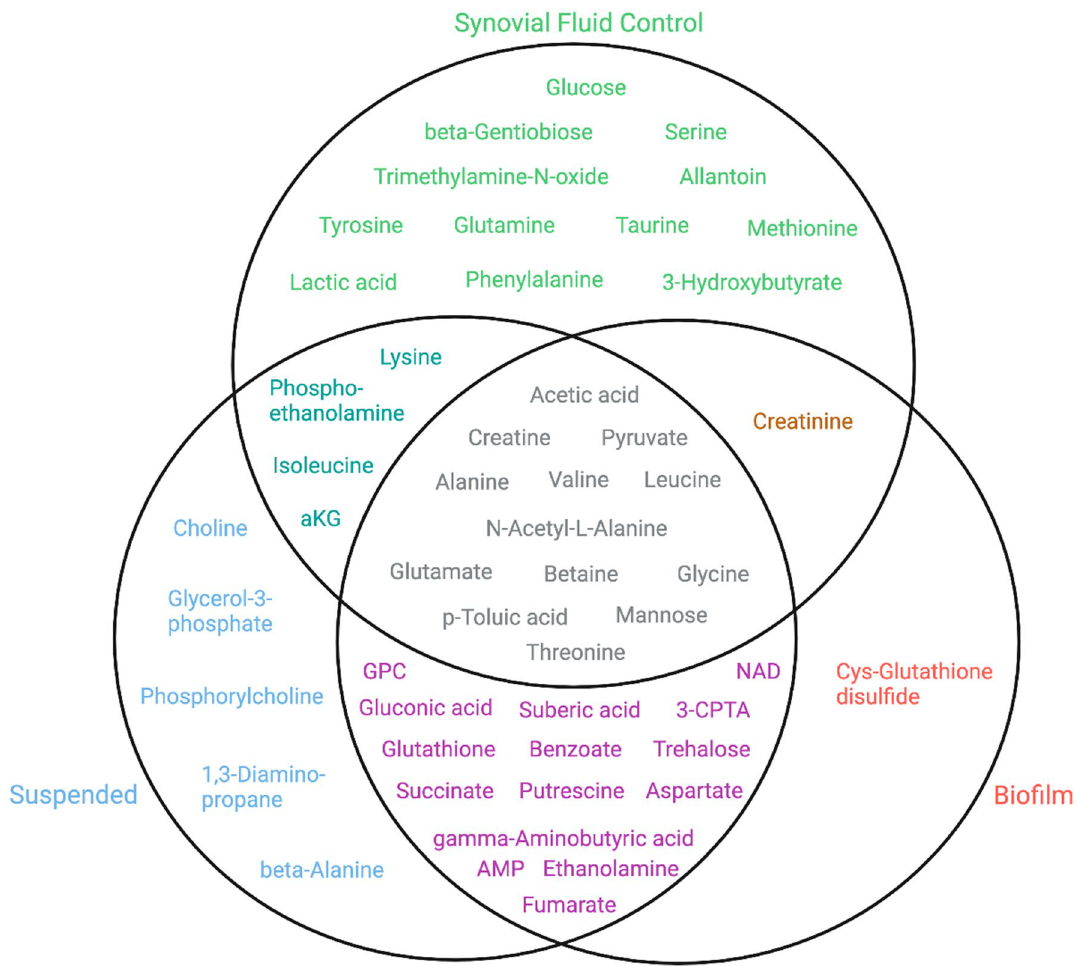
Figure 3. A Venn diagram of metabolites identified in the uninoculated BSF control (green), suspended culture (blue), and lawn biofilm (red) samples. The overlap of circles indicates metabolites detected in more than one sample type ( aKG alpha-ketoglutarate, GPC glycerophosphocholine, NAD nicotinamide adenine dinucleotide, AMP adenosine monophosphate, 3-CPTA 3-carboxypropyl-trimethyl-ammonium, Cys